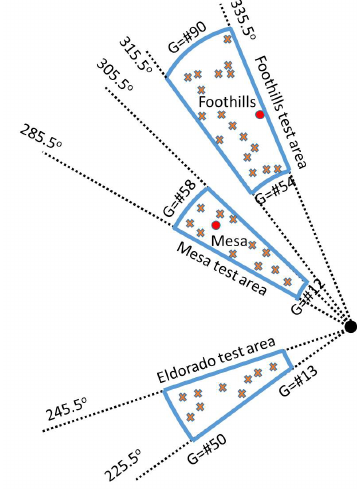
Figure 5. Resolution area defined by the targets in Mesa and Foothills